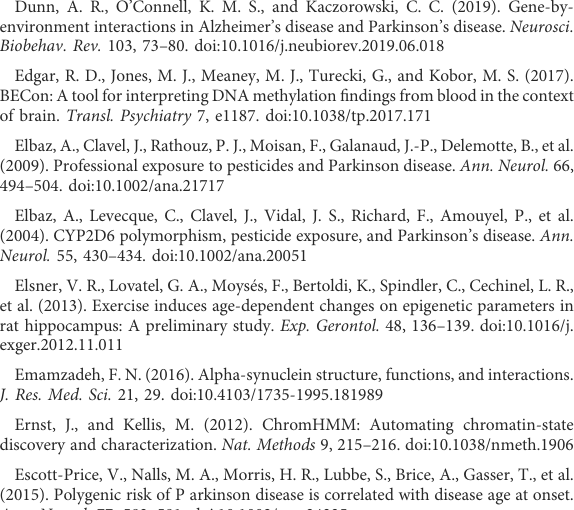
Table 1:. Environ. Epigenet. 2, dvw016.